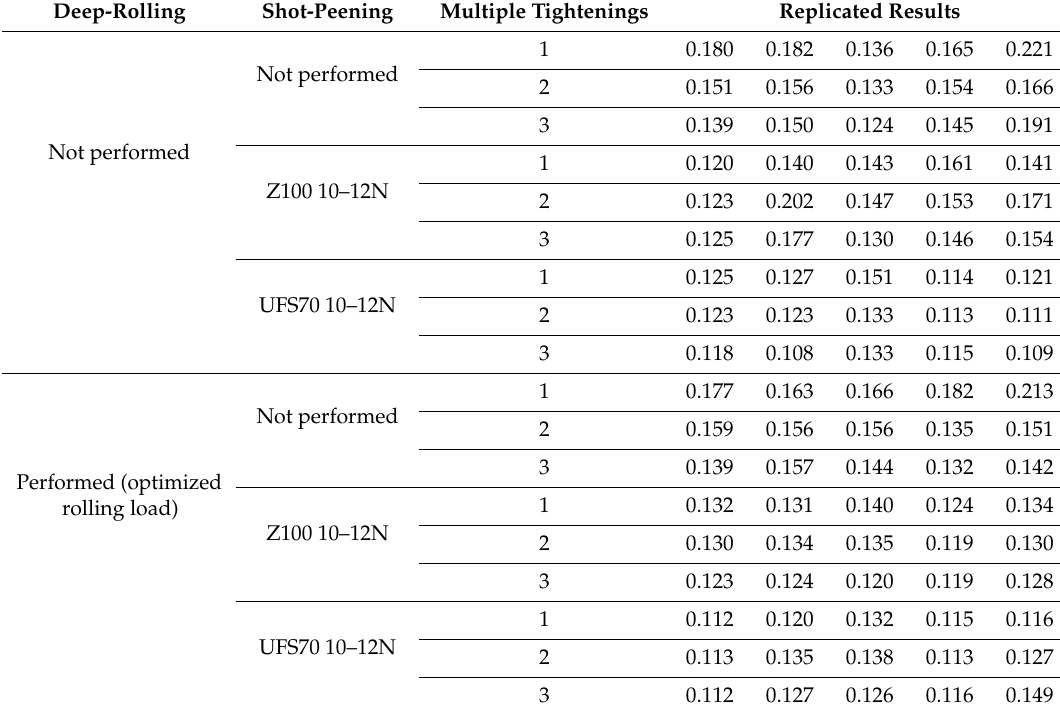
Table 6. Results in terms of total friction coe ffi cients ( µ tot ) in grease lubricated conditions.